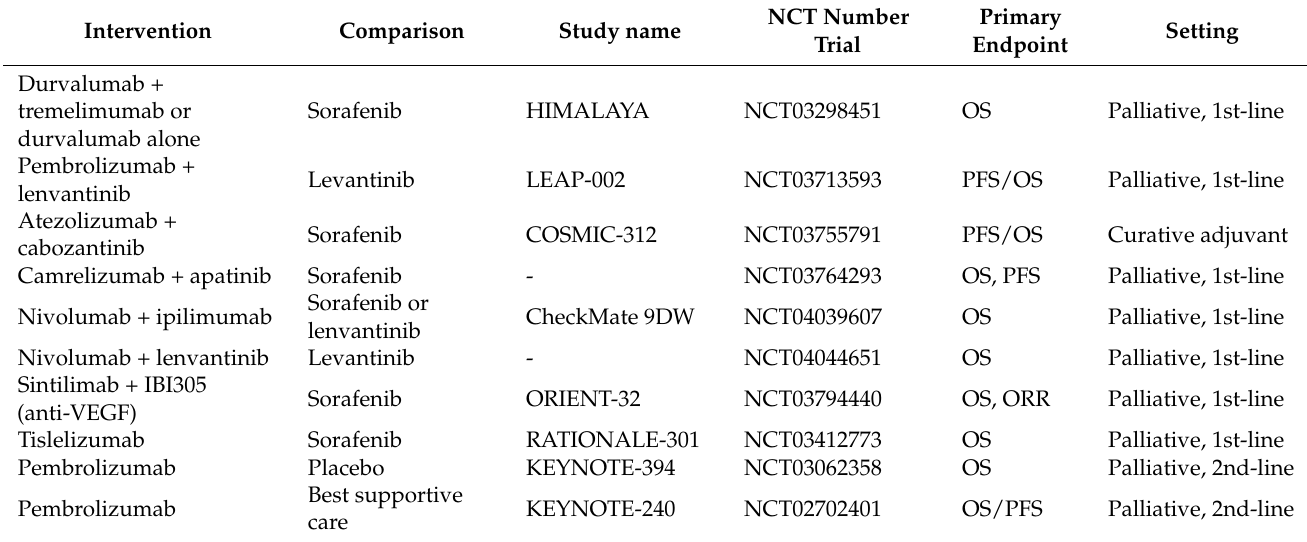
Table 4. Ongoing phase III trials investigating immune checkpoint inhibitors in patients with advanced HCC. Intervention